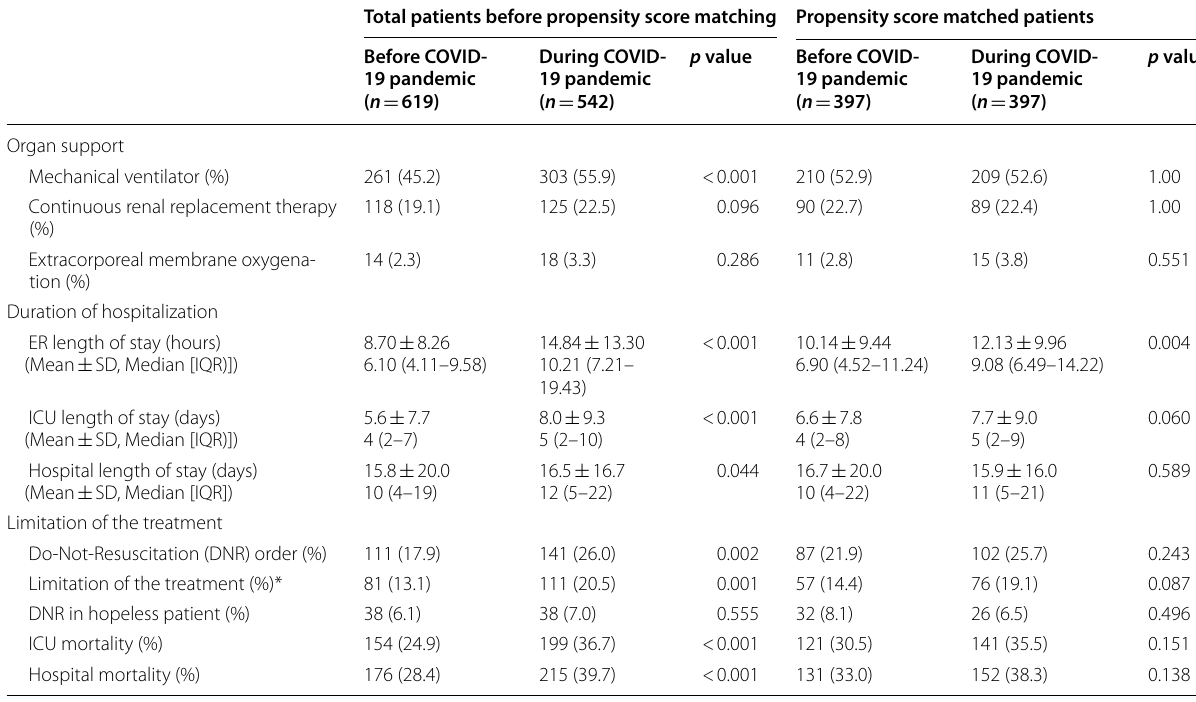
COVID, corona virus disease; ER, emergency room; SD, standard deviation; IQR, interquartile range; ICU, intensive care unit * The number of patient who refused intubation, renal replacement therapy, transfusion, vasoactive agent or chemotherapy